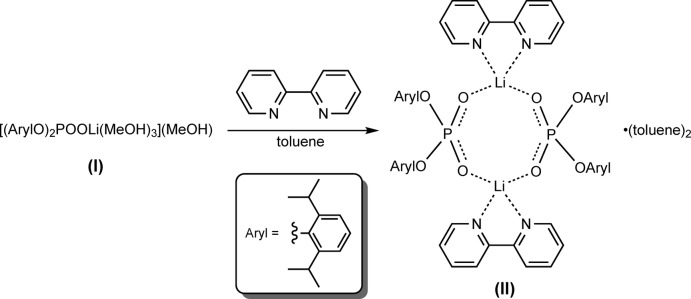
Synthesis of {[(2,6-iPr2C6H3O)2PO2]Li(bipy)}2(C7H8)2, (II).